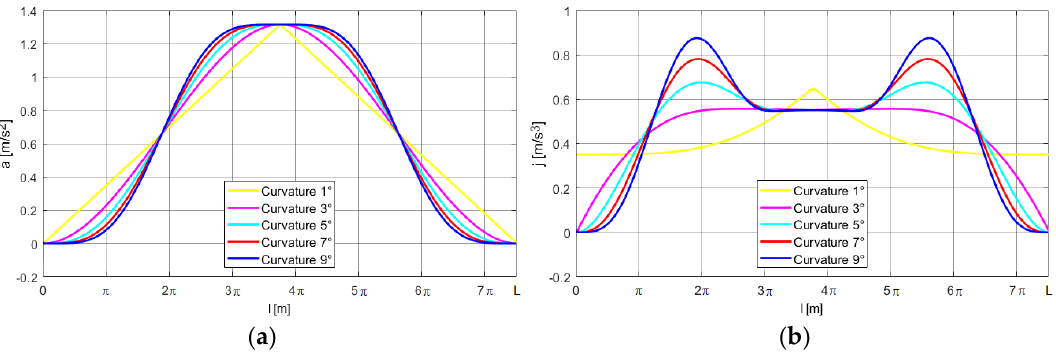
Figure 6. The course of the resultant kinematic quantities for the HoL trajectory: ( a ) acceleration; ( b ) jerk.